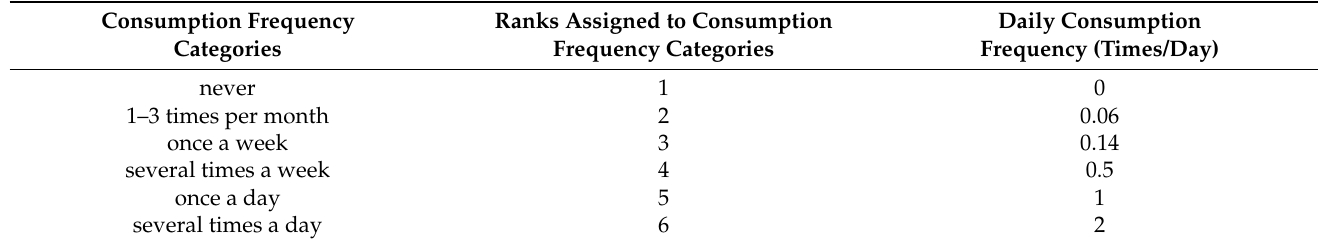
Table 2. Ranks and/or indicators of daily consumption frequency (times/day) which applied to process and interpret the results of eating habits and food